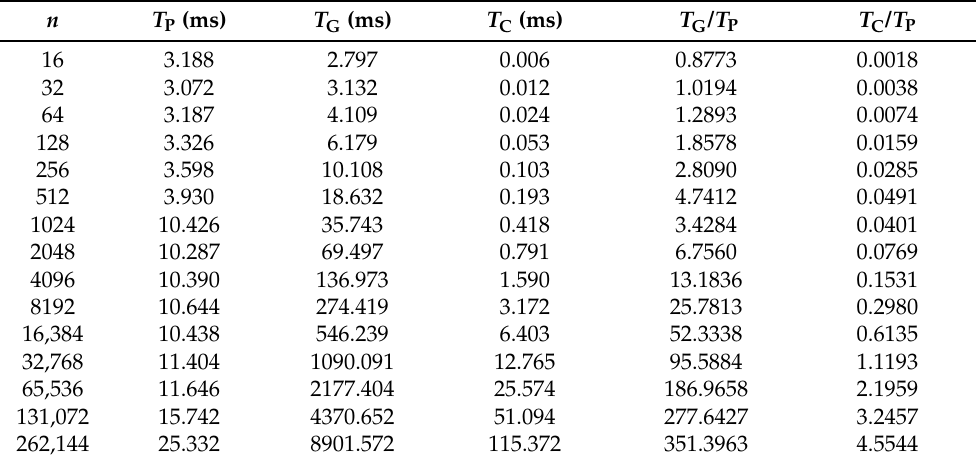
Table 2. Running times and speedups for the CPU (C); GPU sequential (G); and GPU parallel (P) prefix sum